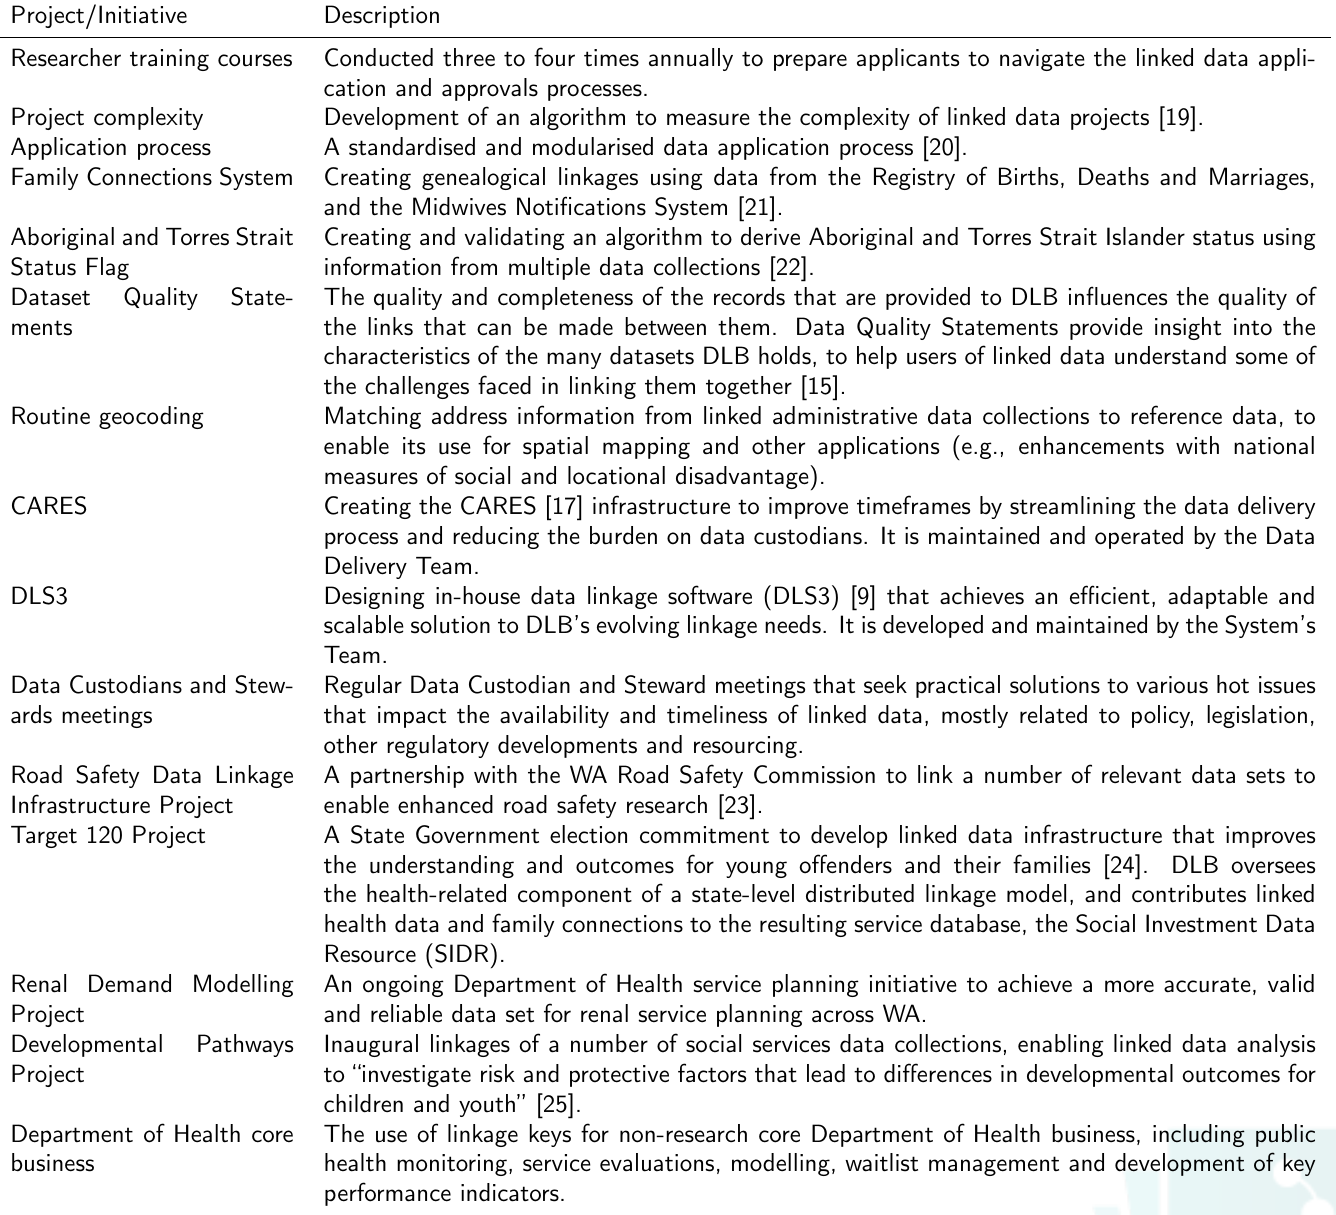
Table 2: DLB Innovations, Precedents, and Pioneering